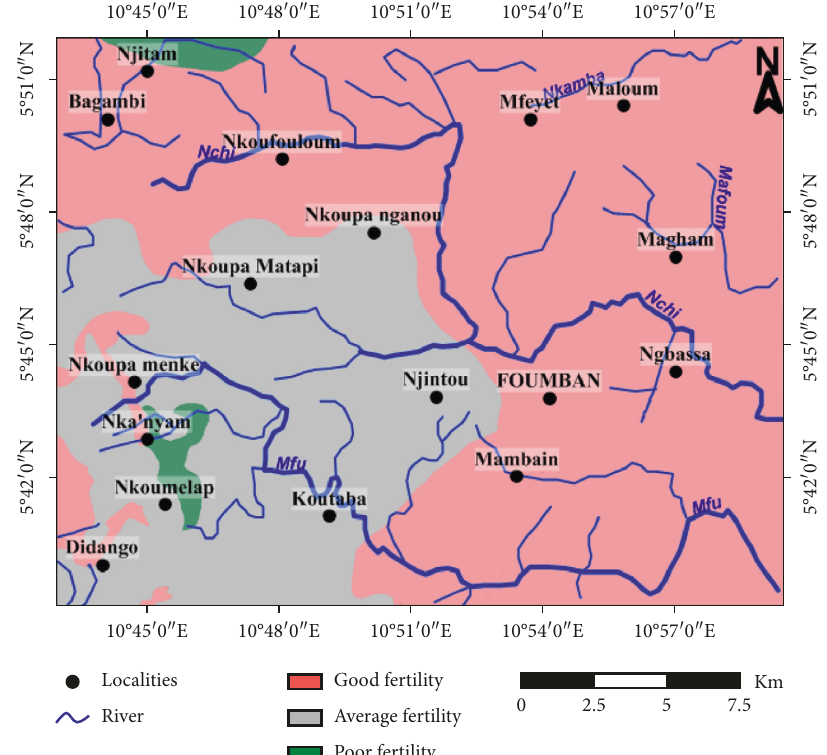
Figure 8: Foumban soil fertility